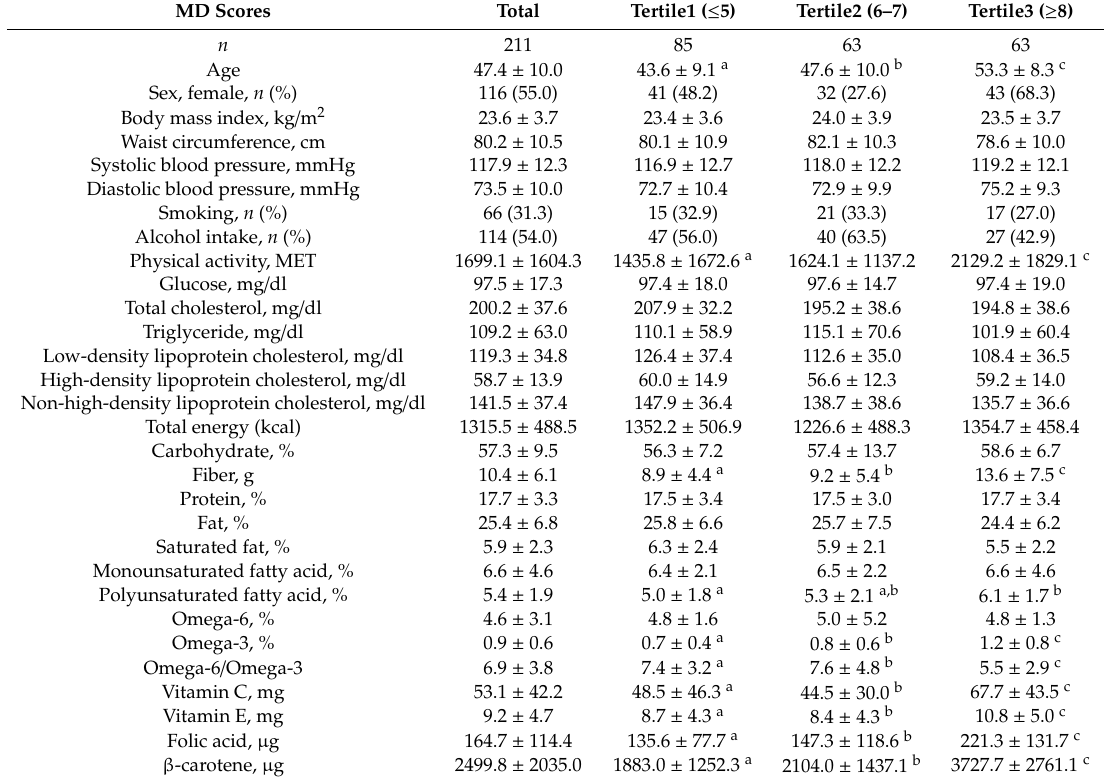
Table 1. Clinical characteristic of the study population according to the Mediterranean diet (MD) score